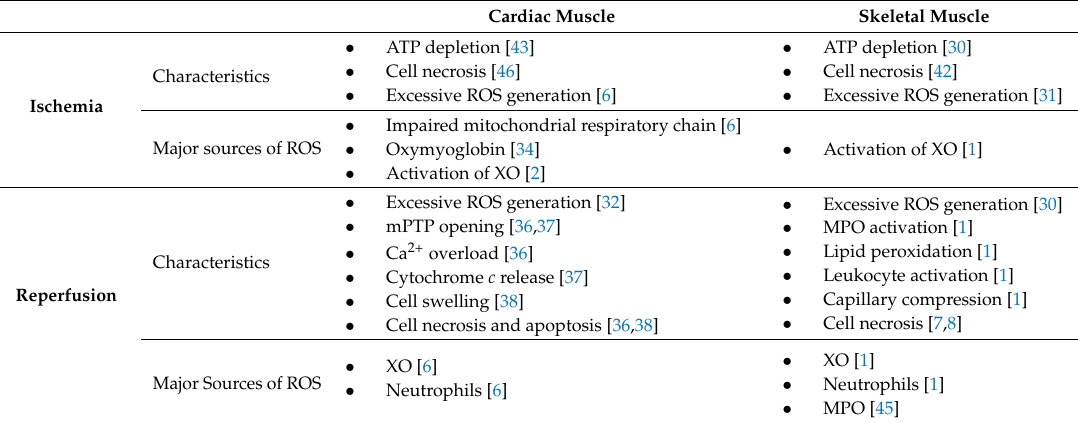
Table 1. Characteristics of cardiac and skeletal muscle injury and major sources of ROS during ischemia and